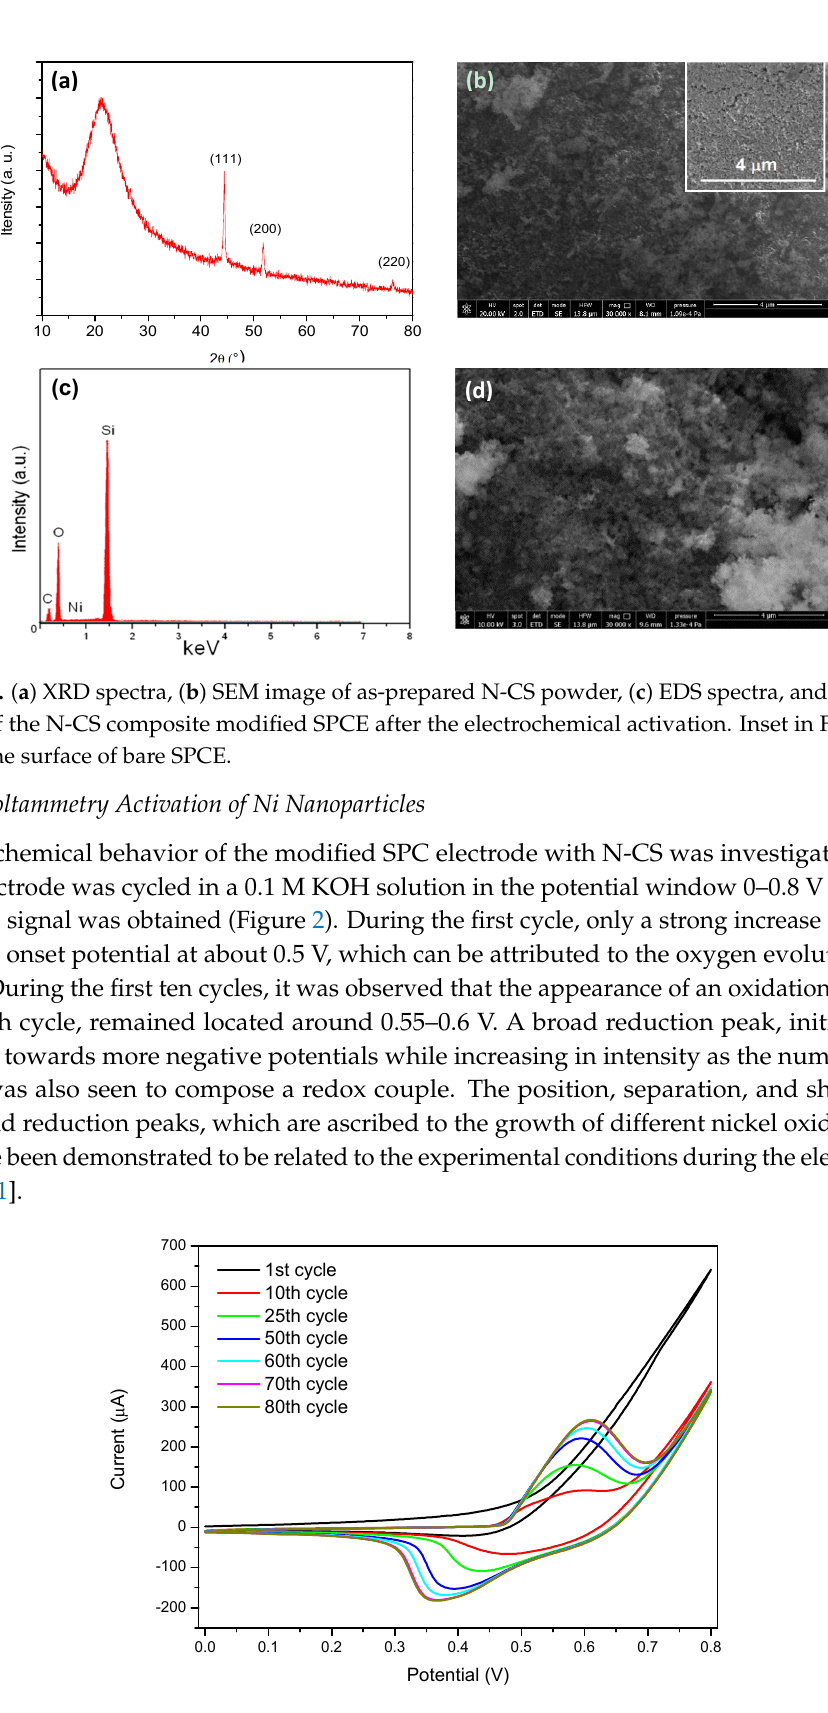
Figure 2. Evolution of the CV curves with number of cycles of N-CS modified SPCE in 0.1 M KOH at a scan rate of 50 mVs − 1 .